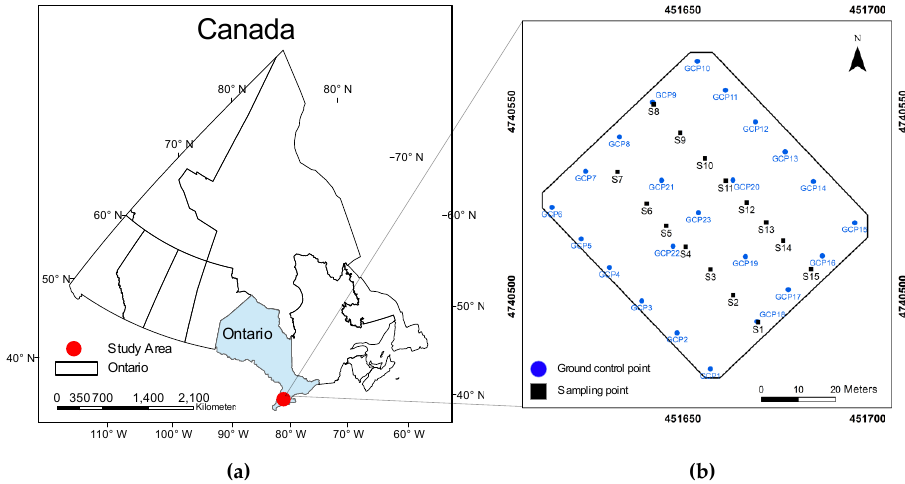
Figure 1. Study area and sampling points in the field. ( a ) The study area in Ontario, Canada. ( b ) The sampling points in the study area. The blue points are the ground control points, and the black squares are ground-measured sampling points.